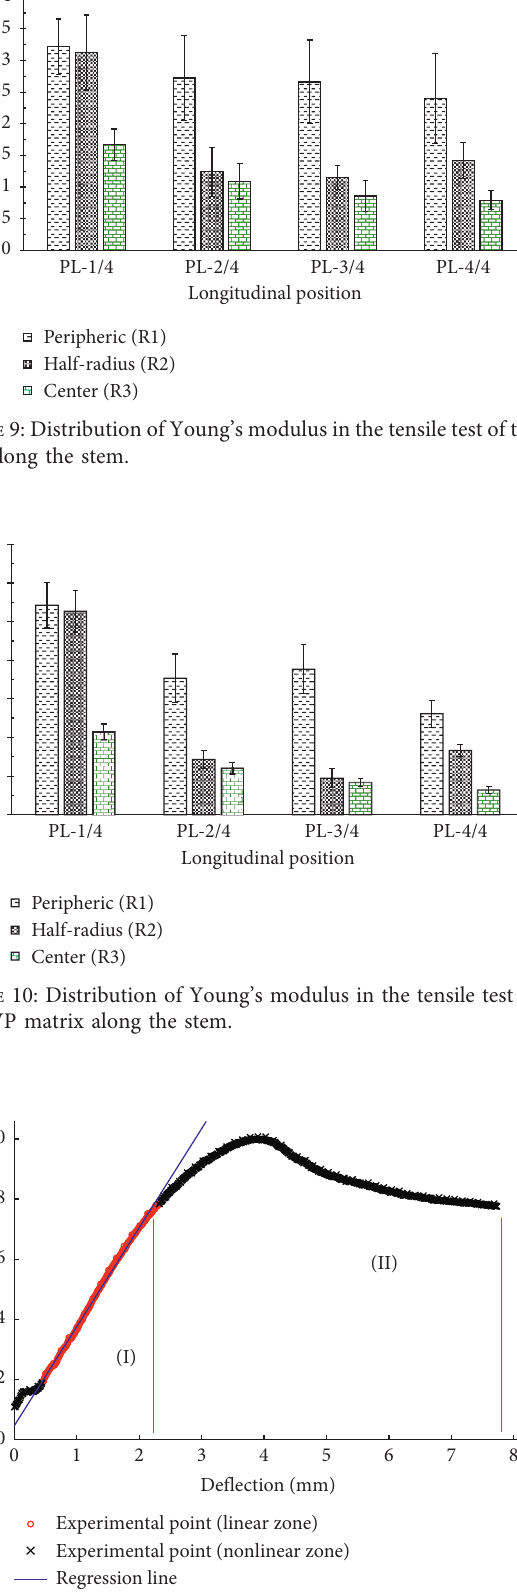
Figure 11: Force versus deflection curve for the three-point bending test of a RVP sample along the stem.